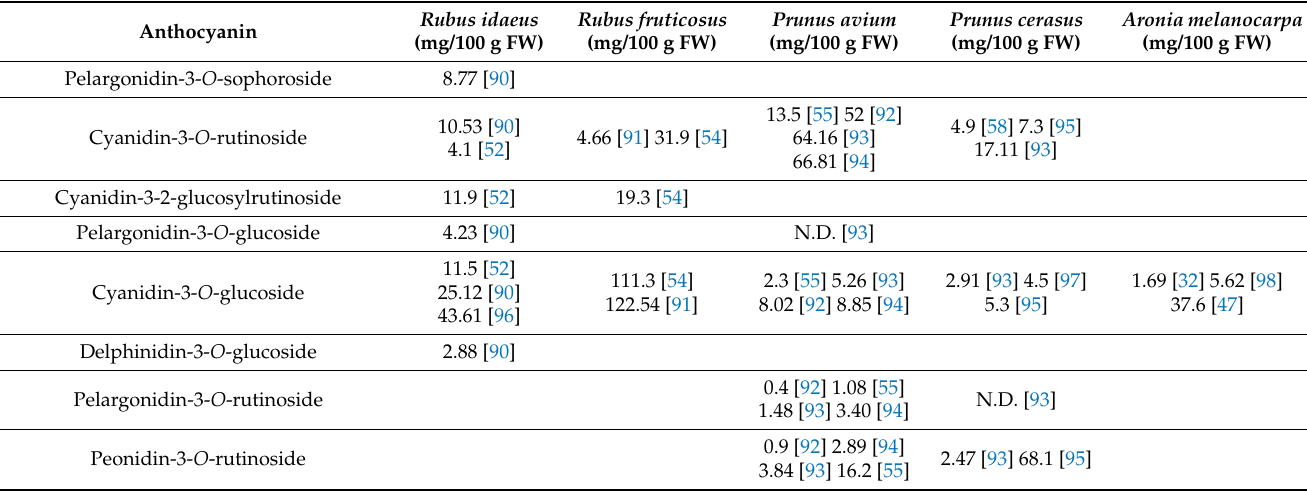
Table 7. Specific anthocyanin contents found in the fruits of Caprifoliaceae